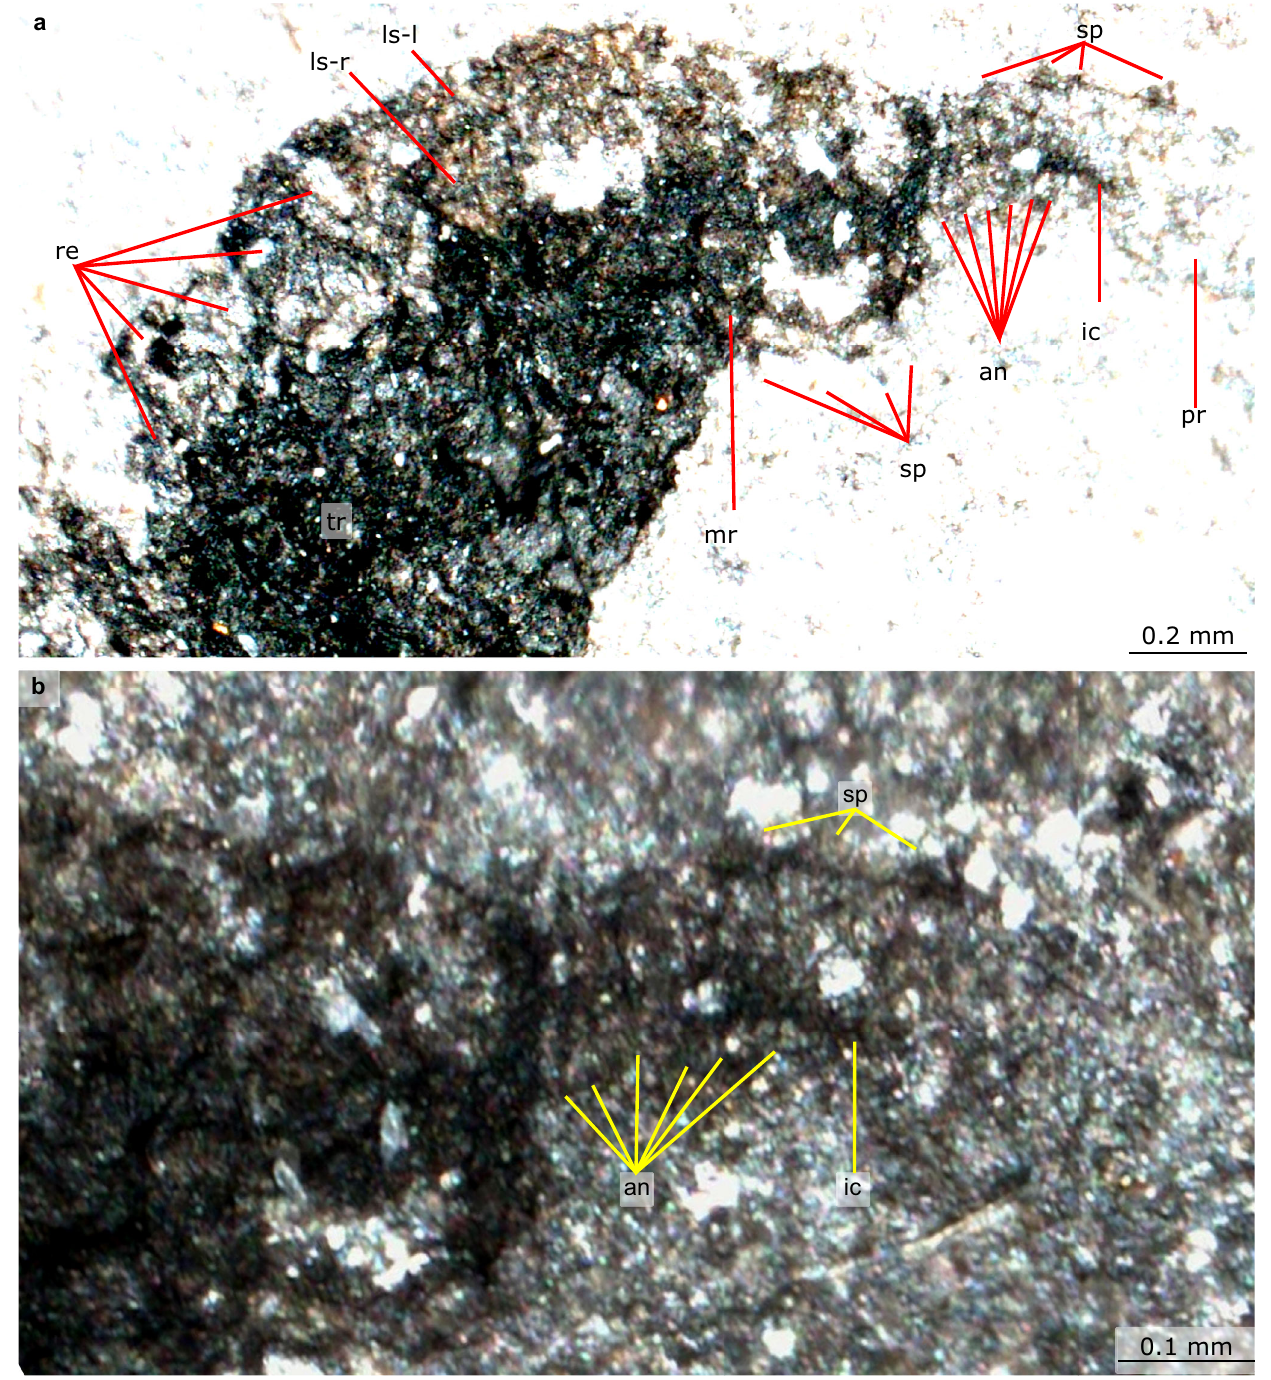
Fig. 7 | Details of anterior of Castle Bank euarthropod A (NMW.2021.3G.8). a Anterior of head including lateral sclarites, rectangular elements and spinose proboscis with annulations ( b ) Details of spinose proboscis and annulations; an